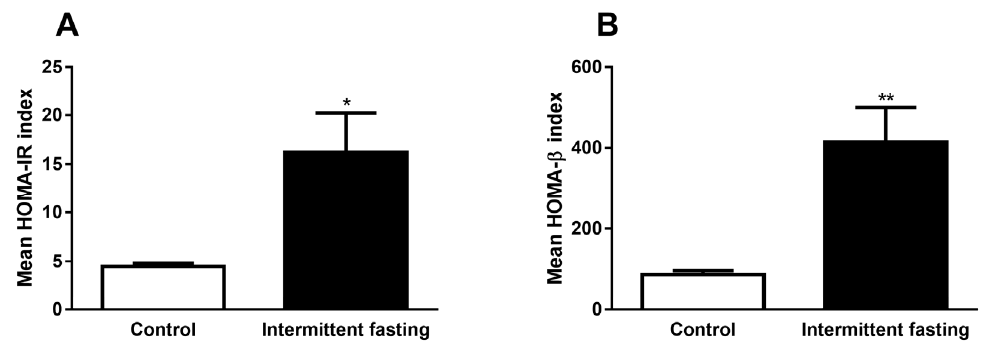
Figure 9. ( A ) Homeostasis model assessment of insulin resistance (HOMA-IR) and ( B ) homeostasis model assessment of β -cell function (HOMA- β ) indexes of Wistar rats submitted to IF for 12 weeks. The results are presented as the mean ± standard error of the means (SEM) with 5 different animals for each group. * p <0.05 and ** p <0.005 compared to the control, as indicated by Student's t-test.